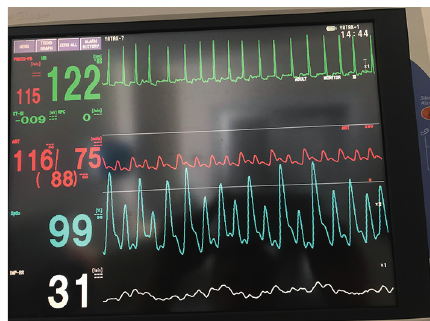
Figure 2: The bedside monitoring image showing AF-induced polymorphic artery trace, and the alterations in pulse oximeter were in accordance with polymorphic artery